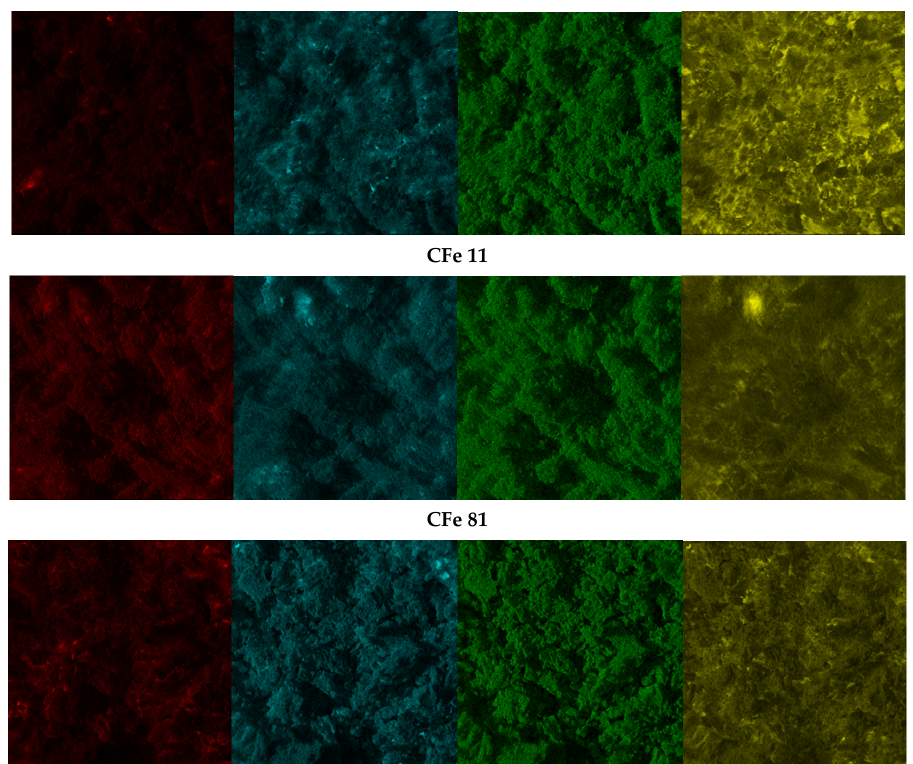
Figure 4. EDX images of CFe12, CFe11, and CFe81. Colour code: carbon in red, oxygen in blue, nitrogen in green, and iron in yellow. XRD patterns (Figure 5a) were acquired in order to identify the phases in the samples. The diffraction peaks matched very well with the reported data of magnetite (JCPDS No. 19-0629), thus confirming that the synthesis was effective in producing the target phase. When the paper:iron ratio was high, resulting in the presence of more carbon, such as for the CFe41 and CFe81 samples, the XRD patterns showed a lower crystallinity of the Fe 3 O 4 phase, as suggested by the intensities and widths of the peaks. This could be due to the sluggish kinetics of the formation of magnetite, considering that the iron precursor was likely entrapped in the cellulose fibres and less exposed to the nitrogen atmosphere. Ad- ditionally, cellulose might have needed more time to decompose and to effectively con- tribute to the carbothermal reduction at the same calcination temperature, considering its high quantity.